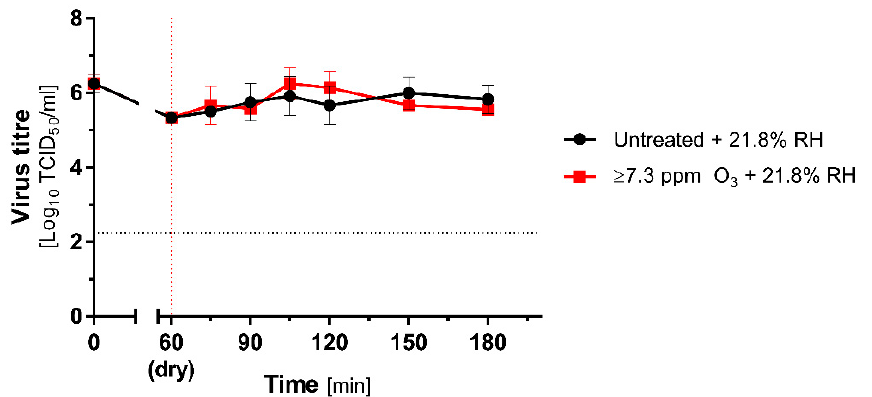
Figure 3. Inactivation of the coronavirus during the ozone treatment under low RH (21.8% RH). Comparison of mean (±SD, n = 3) titres of MHV recovered from contaminated carriers subjected to ozone treatment ( ≥ 7.3 ppm; red lines) and untreated (black lines) at 21.8% RH. Black dotted line represents the 4 logs virucidal efficiency threshold with respect to the initial titre; the red dotted line represents the beginning of O 3 treatment.